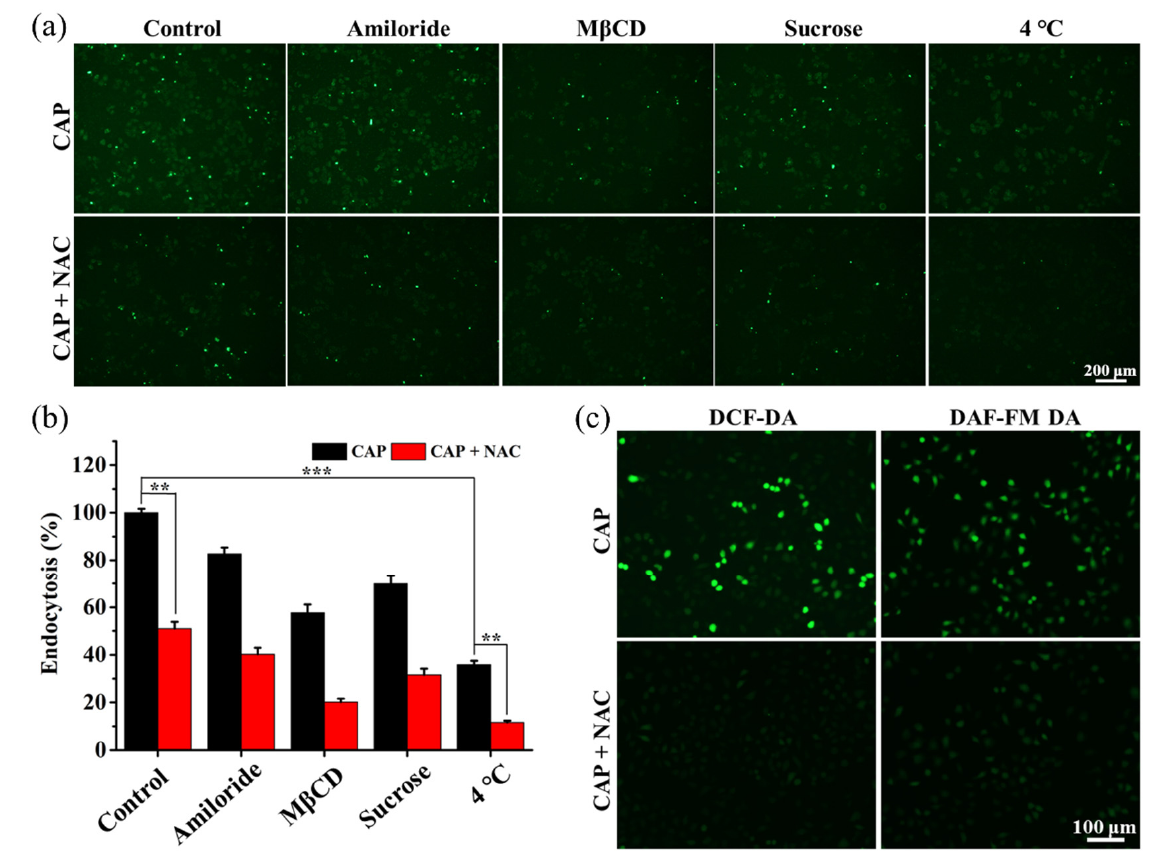
Figure 3. Mechanism of CAP-mediated cellular transport of Cas9sg: ( a ) Fluorescence images of Cas9sg-488 uptake by the MCF-7 cells pre-treated with different endocytosis inhibitors and at a low temperature (4 °C) upon CAP exposure for 80 s (C Cas9sg-488 = 8 nmol L − 1 ); ( b ) Inhibition of endocytosis by different inhibitors and low temperature of 4 °C upon CAP exposure for 80 s; ( c ) Fluorescence images of MCF-7 cells treated with the DCFH-DA and DAF-FM DA probes for 2 h in the presence of the RONS scavenger NAC after the CAP treatment for 80 s. The data are shown as mean ± SD ( n = 3). (**) p < 0.01, and (***) p < 0.001.